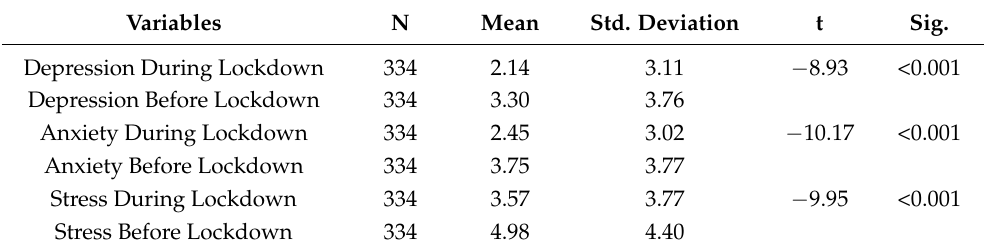
Table 3. Pair samples t -tests of participants’ psychological states before and during COVID-19 lockdown.